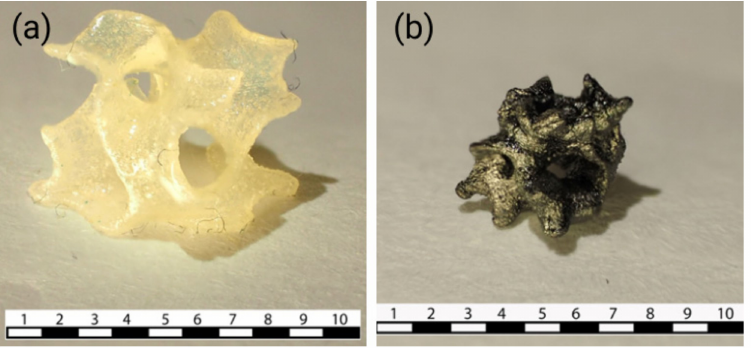
Figure 1. An object 3D-printed from the photopolymer composition with concentration of ZIF-8 5 wt.% before ( a ) and after ( b ) the